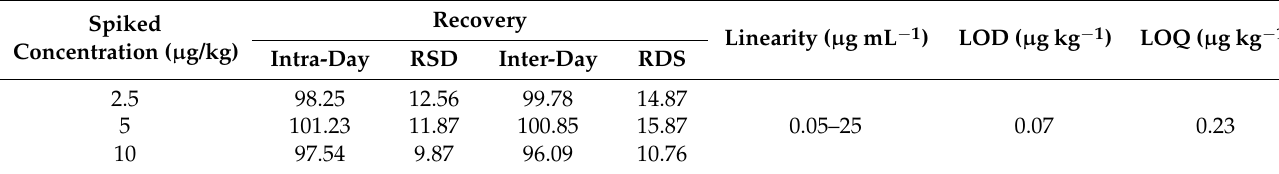
Table 2. Data regarding method